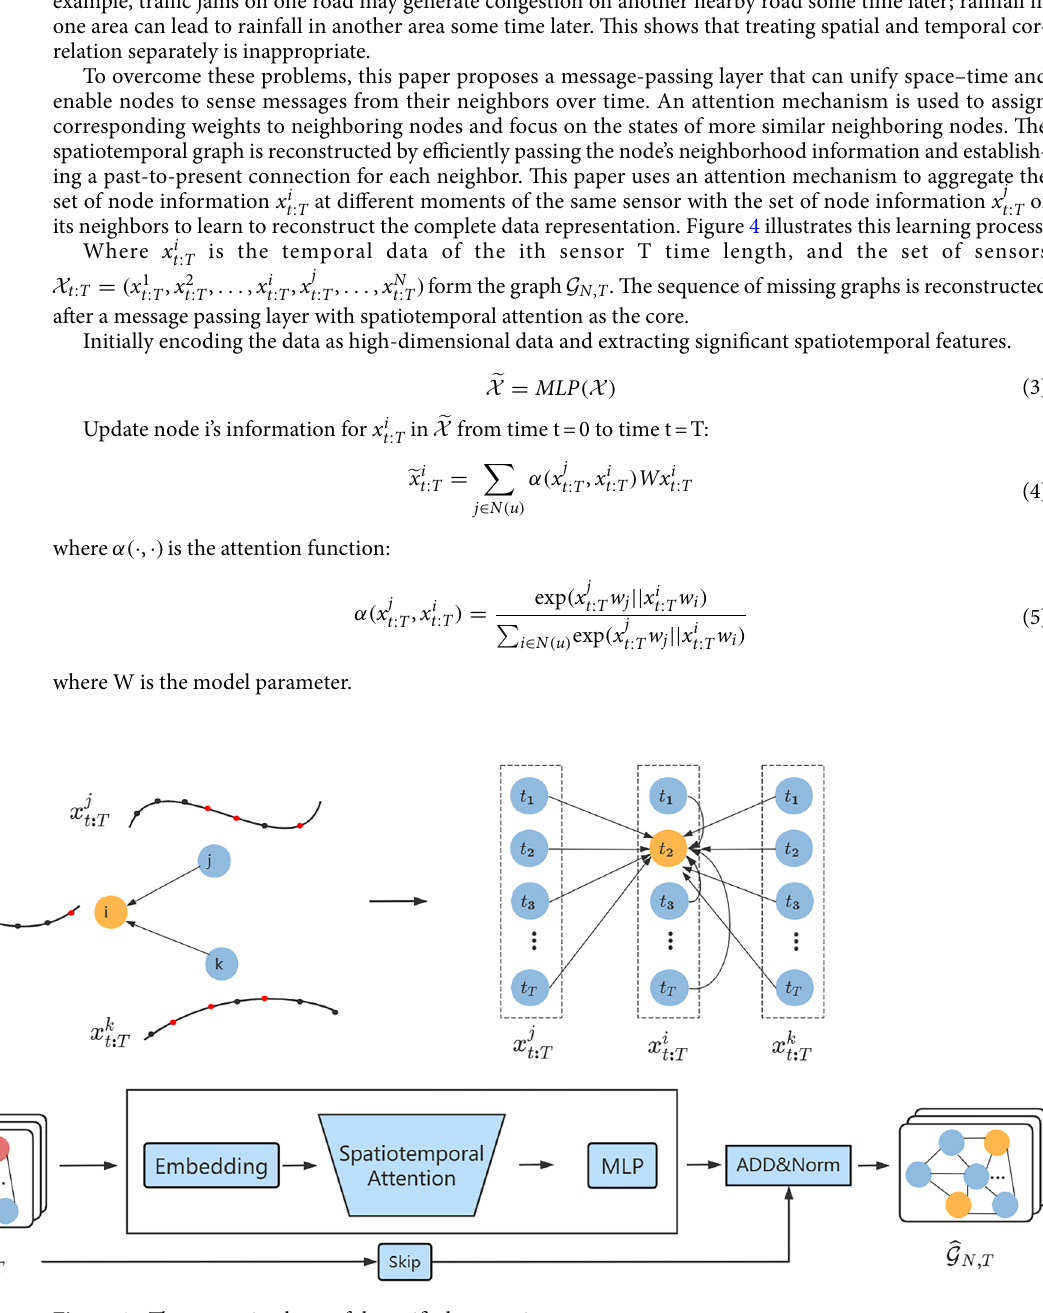
Figure 4. The messaging layer of the unified